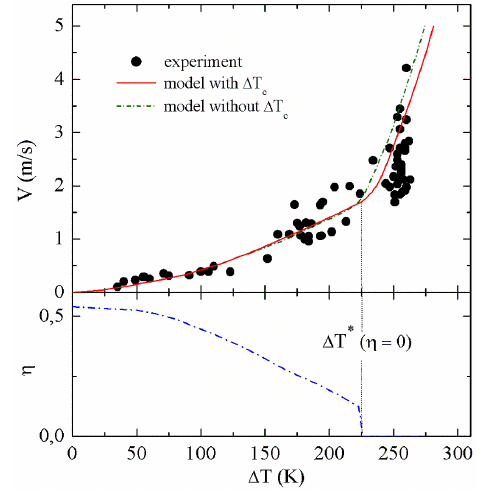
Figure 12. Top: Dendrite growth velocity V as a function of undercooling ∆ T measured by use of a high-speed video camera (full circles) and computed by applying the sharp interface model, with (solid line) and without (dashed-dotted line), taking into account small constitutional effects due to the shift of the congruent melting point in the kinetic phase diagram. If any constitutional contributions are neglected the temperature characteristics of V (∆ T ) does not change with the exception that the sharp increase of V sets in at a critical undercooling, being about 25 K smaller (dashed-dotted line). Bottom: The order parameter η is shown as a function of undercooling as inferred from the analysis of the experimental